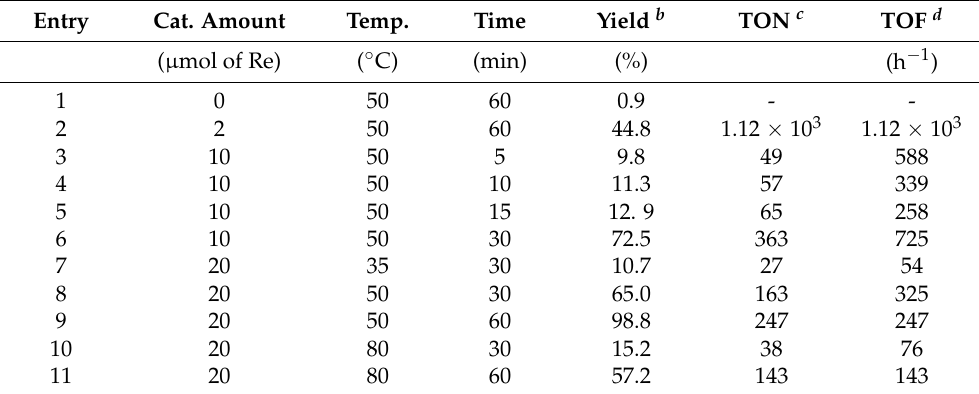
Table 2. MW-assisted oxidation of 1-phenylethanol catalysed by [Re 2 (CO) 10 ] (homogeneous conditions) a .